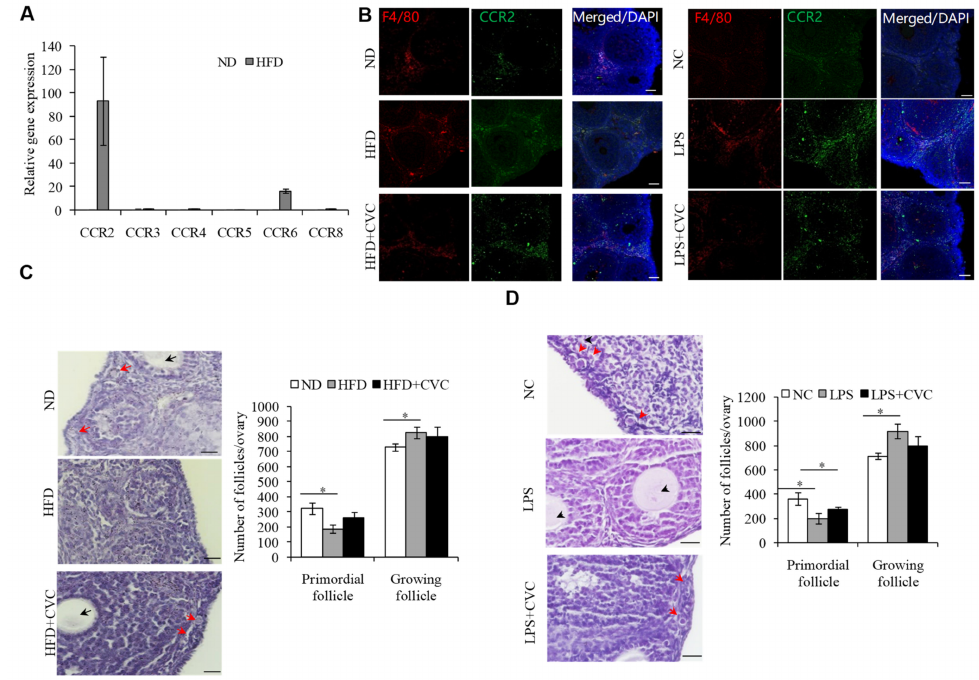
Figure 3. M1 macrophage infiltration into the ovaries is the main reason for the overactivation of primordial follicles in HFD mice. ( A ) qPCR analysis of the macrophage chemokine receptors in the ovaries of the ND and HFD mice. ( B ) Immunofluorescence detection of CCR2 (green) and F4/80 (red) in ND, HFD, and HFD+CVC mice ( left panel ), or in the control, LPS, and LPS+CVC treated mice ( right panel ). DNA was stained with DAPI (blue). Scale bar = 50 µ m. ( C ) Representative H&E staining images and follicle number counts in the ovaries of HFD mice treated with CVC ( n = 3), compared to the HFD mice ( n = 5). ND mice were used as controls ( n = 5). Scale bar = 50 µ m. ( D ) Representative H&E staining images and follicle number counts in the ovaries of the control, LPS, and LPS+CVC treated mice ( n = 5). Scale bar = 50 µ m. Red arrows represent primordial follicles. Black arrows represent growing follicles. * p <